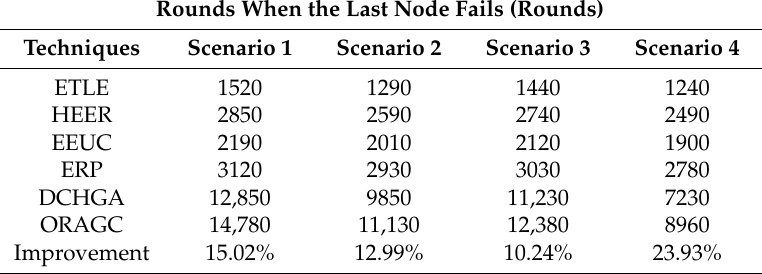
Table 3. Running rounds when the last node fails of six algorithms in four different scenarios, and the improvement is